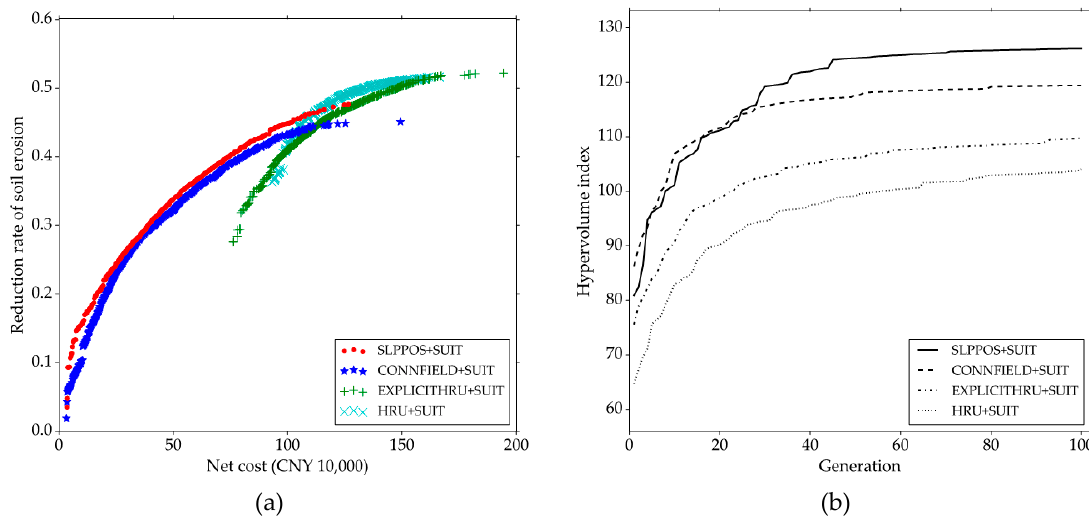
Figure 7. Comparisons among four types of BMP configuration units applied with the suitable landuse types/slope positions of individual BMPs (SUIT) strategy: ( a ) near-optimal Pareto solutions of the 100th generation, and ( b ) the hypervolume index with generations.